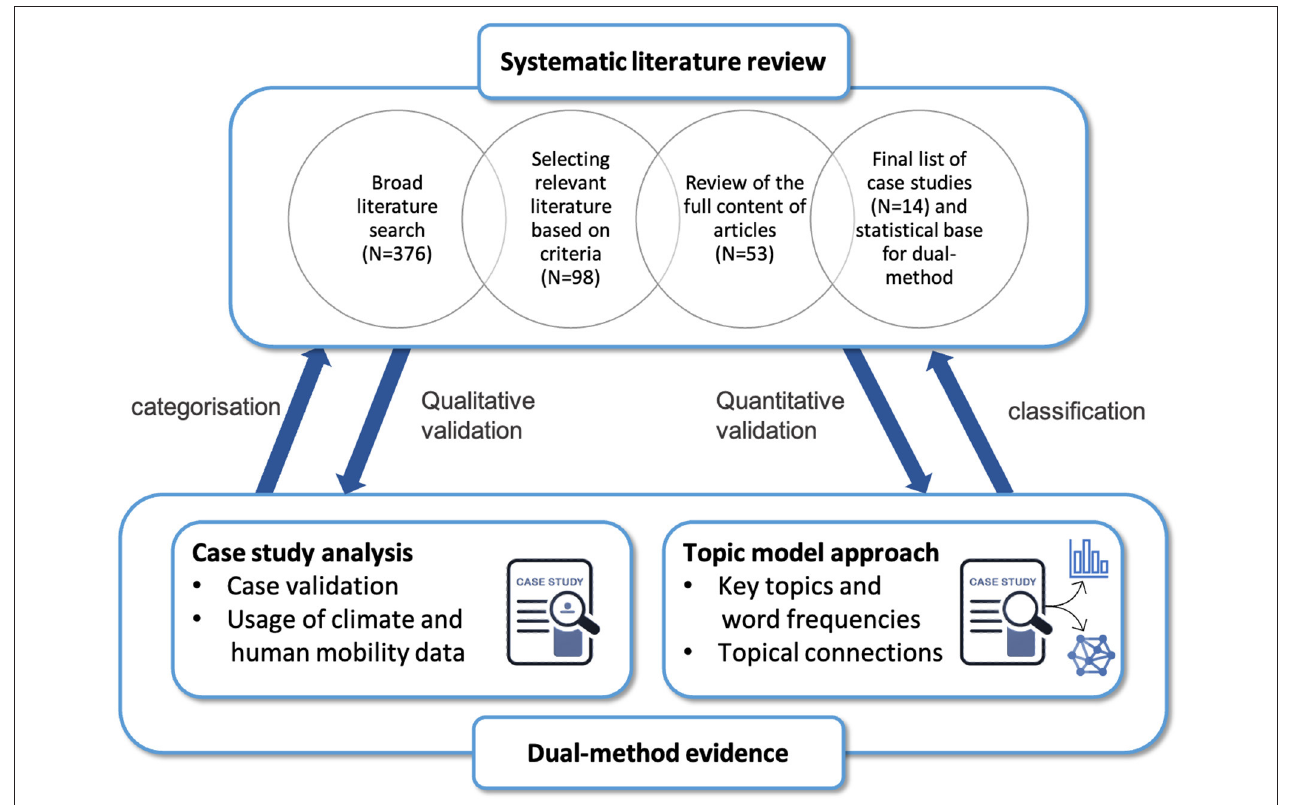
FIGURE 2 | Conceptual framework of the dual-method